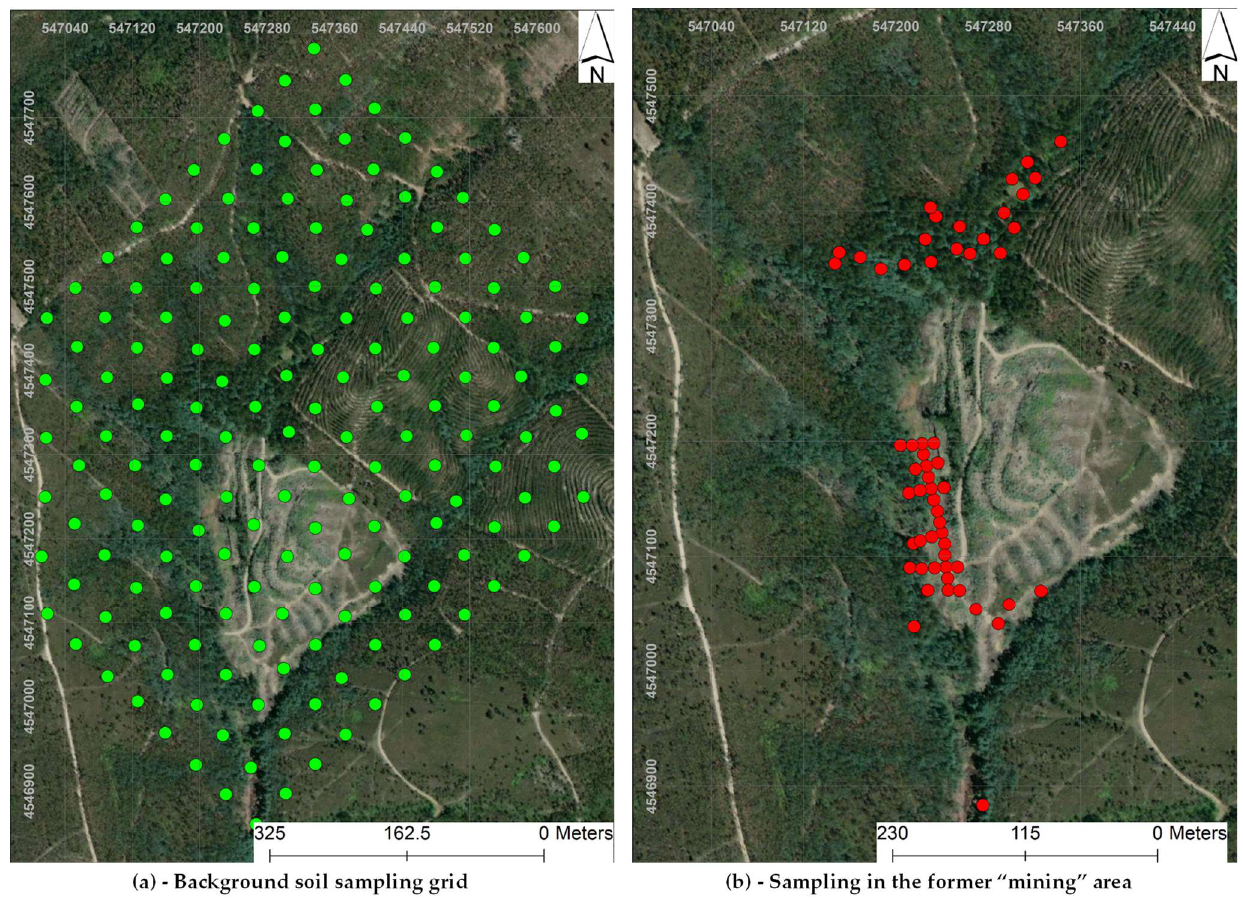
Figure 3 . Localization of sampling. Figure 3. Localization of